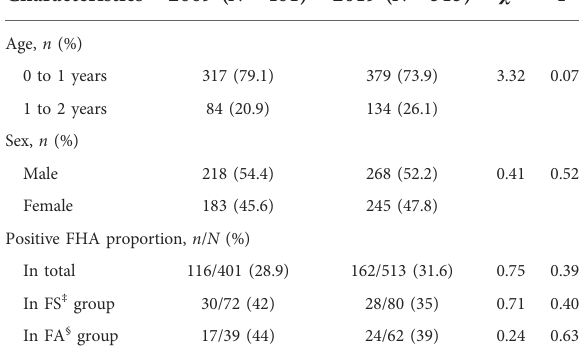
TABLE 1 Demographic characteristics, and the positive FHA † proportions in different participants in 2009 and